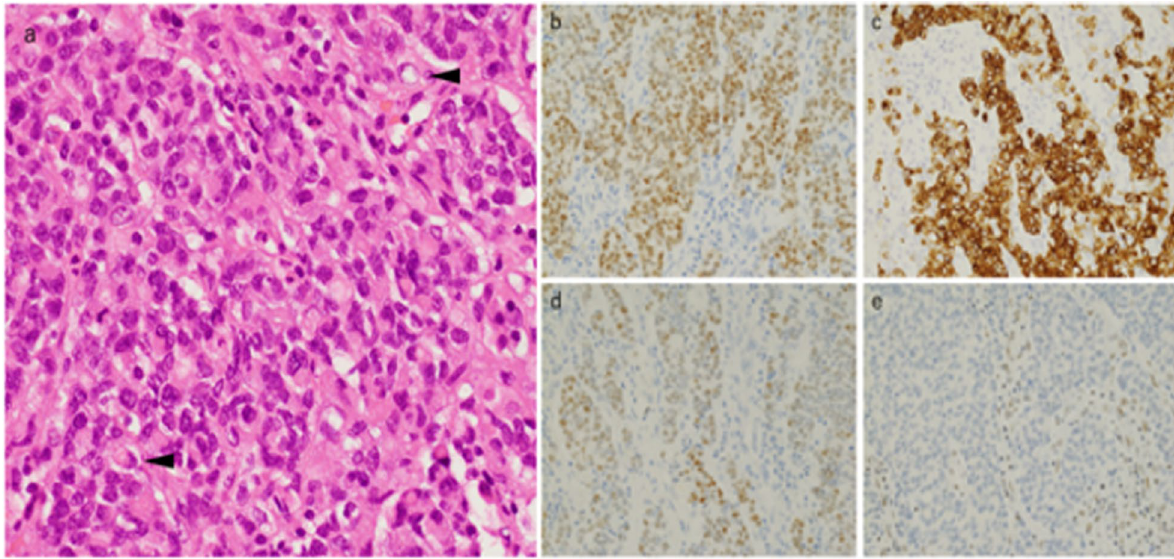
Fig. 3 Histopathological and immunohistochemical findings of the lymph node. a The proliferation of the polygonal neoplastic cells having rich eosinophilic cytoplasm and eccentrically located large round-to-oval nuclei containing nucleoli (hematoxylin and eosin, cells express CDX-2 ( b ), keratin 20 ( c ), and HNF4alpha ( d ) ( 200). e Loss of SMARCB1 expression is observed in the neoplastic cells (note: SMARCB1 × expression is noted in the non-neoplastic cells) ( ×